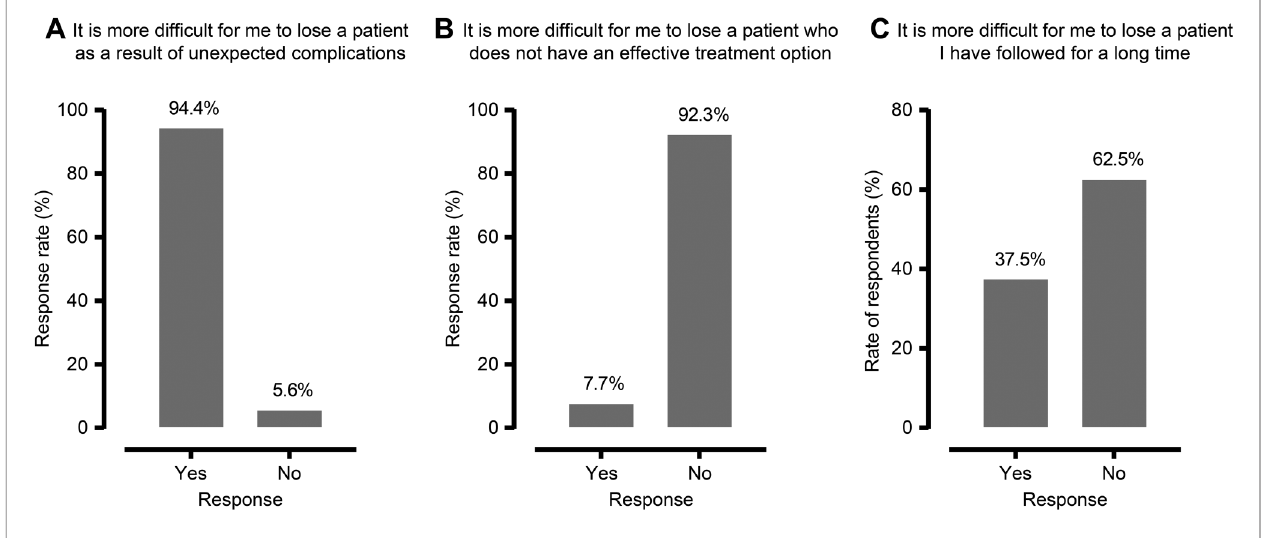
FIGURE 1 | Impact of patient deaths on general